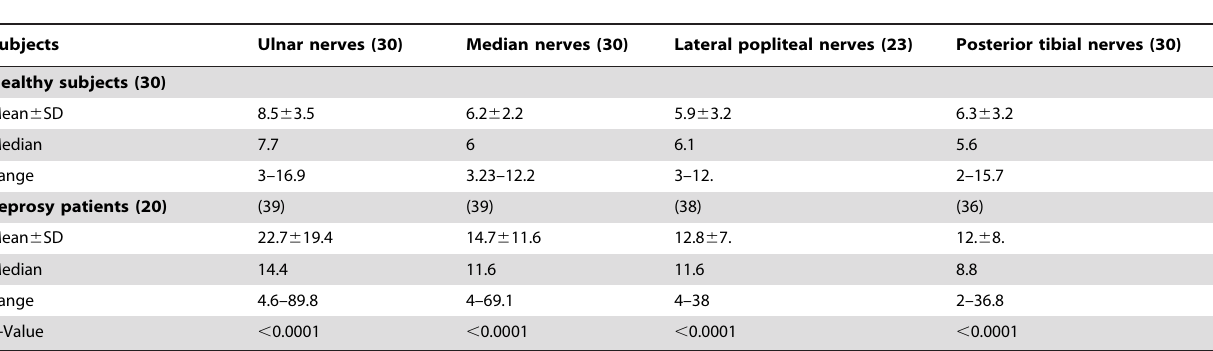
Table 1. Cross sectional area (mm 2 ) of major peripheral nerve trunks of upper and lower limbs of healthy subjects and leprosy